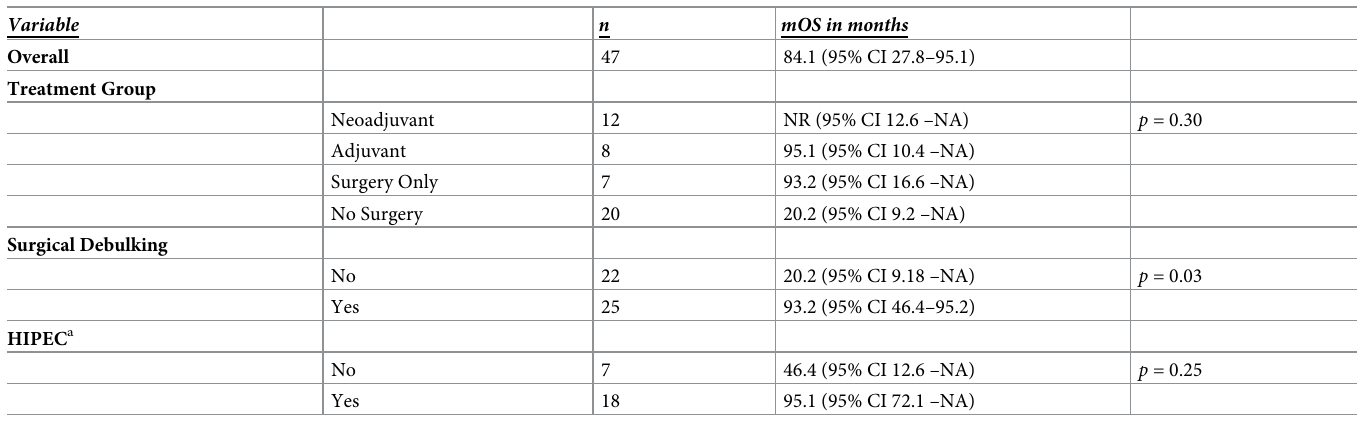
Table 4. Median overall survival (mOS), by